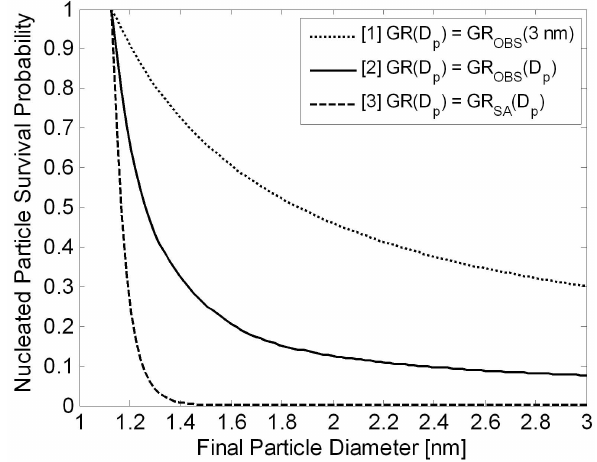
Fig. 3. Survival probability of a nucleated particle ( D p = 1 . 12nm) as a function of final particle diameter for three growth rate sce- narios: (1) GR (D p ) = GR OBS ( 3nm), where the growth rate below 3nm is assumed to be constant and equal to the observed growth at 3nm (14nmh − 1 ) ; (2) GR (D p ) = GR OBS (D p ) , where the growth rate below 3nm is equal to the observed size-dependent growth rate; and (3) GR (D p ) = GR SA (D p ) , where the growth rate below 3nm is equal to the size-dependent growth rate assuming the condensa- tion of only sulfuric acid. Inputs for this model calculation were the observed size-dependent growth rates, growth rates derived from observed [H 2 SO 4 ], and the pre-existing aerosol size distribution ob- tained at 12:40 for the NPF event on 19 September 2010